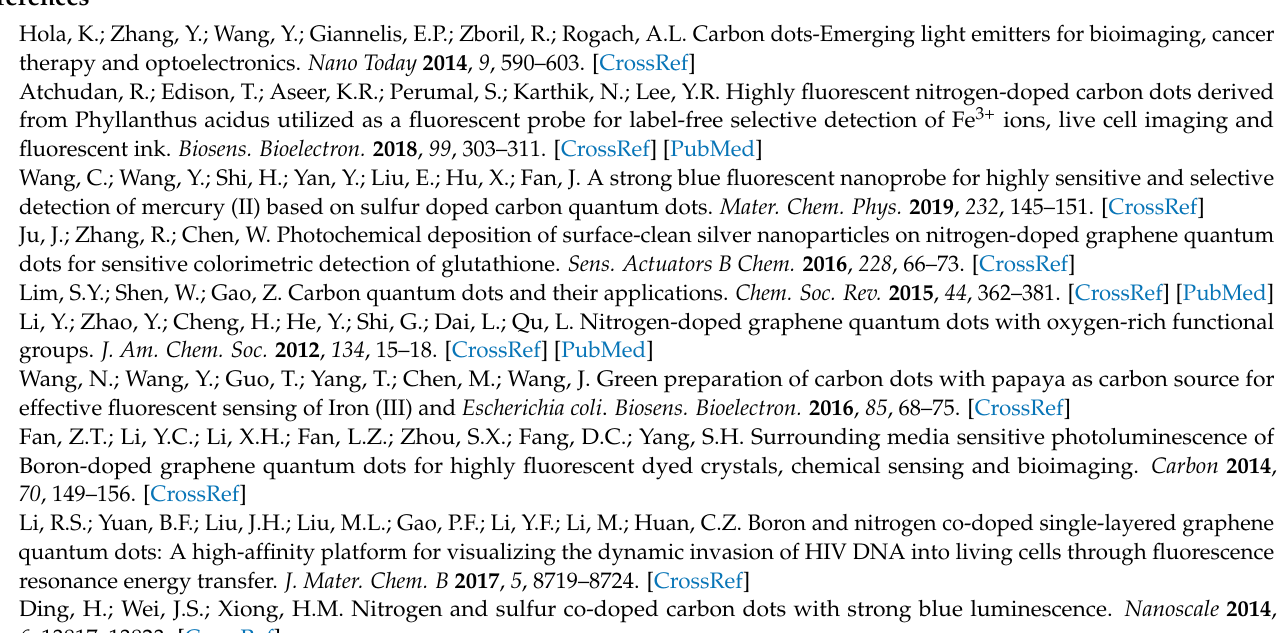
Figure S6. The fluorescence emission spectra of 0.1 wt% poly14-N-CQDs solution in the presence of different metal ions (4 mM) at 380 nm excitation